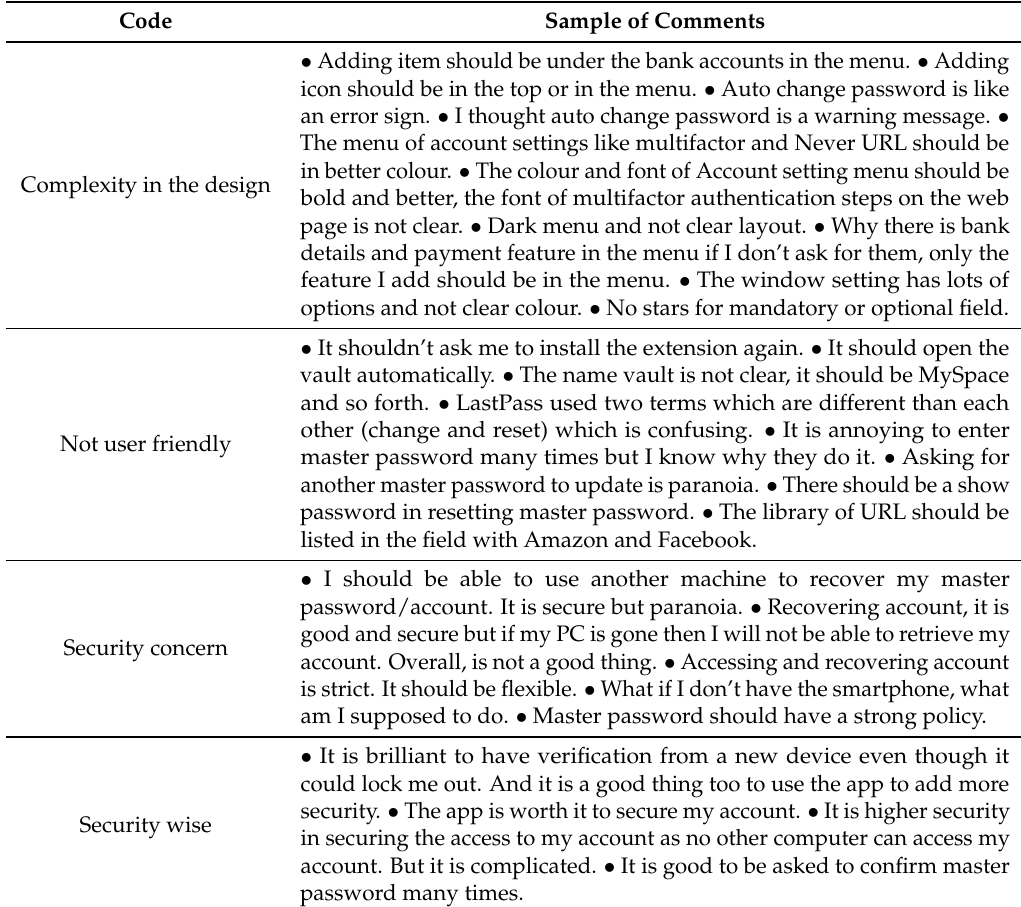
Table 11. Comments sample about LastPass password